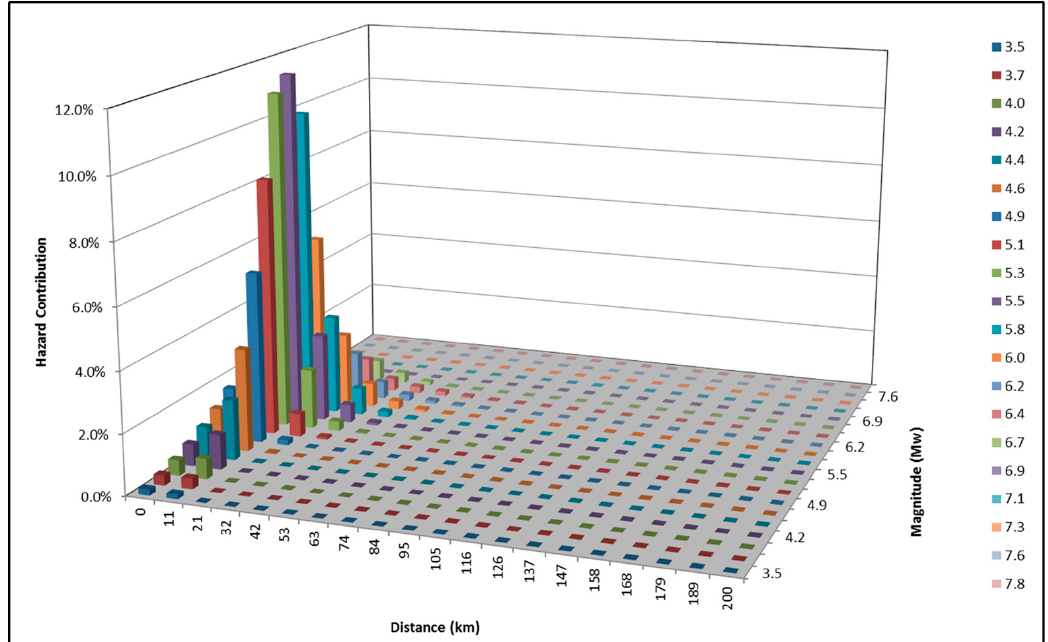
Figure 1. Deaggregation matrix for 12,642 years return period [28].